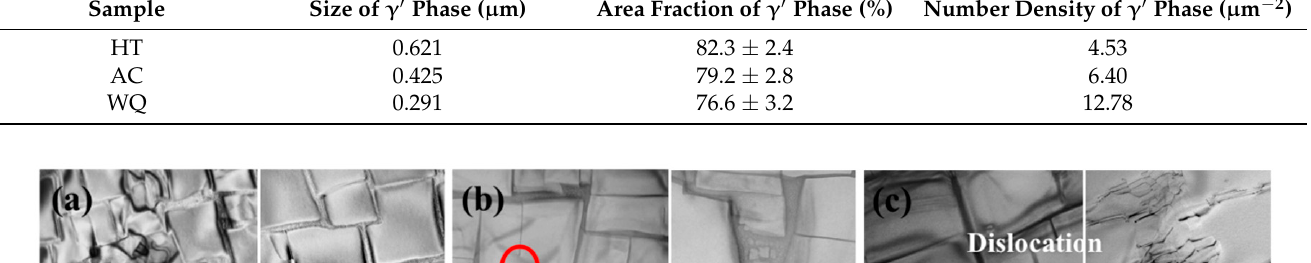
Table 3. Size and area fraction of γ (cid:48) phase after heat treatment under different cooling rates. Sample Size of γ (cid:48) Phase ( µ m)